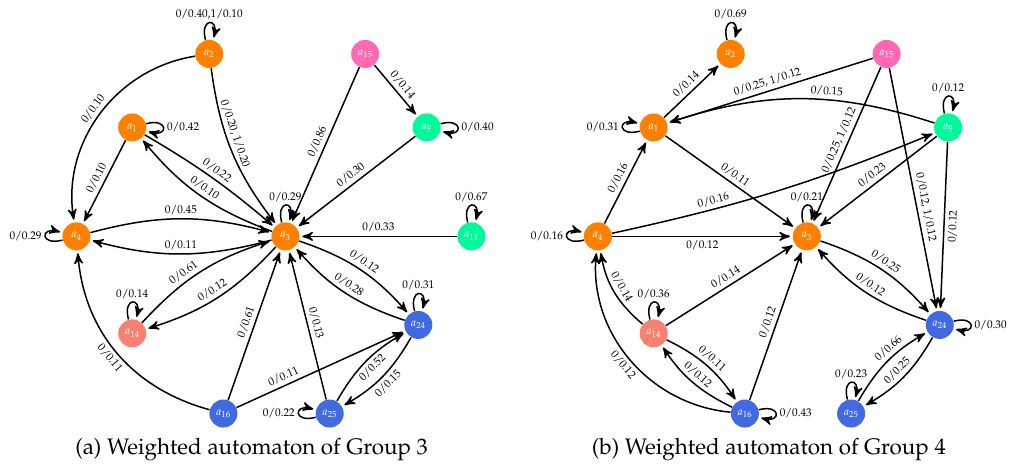
Figure 5. Weighted automata for two profiles; colors indicate the panel to which a given action belongs: orange for Chat, blue for New Bet, green for Proposals, pink for Tutorial and salmon for My